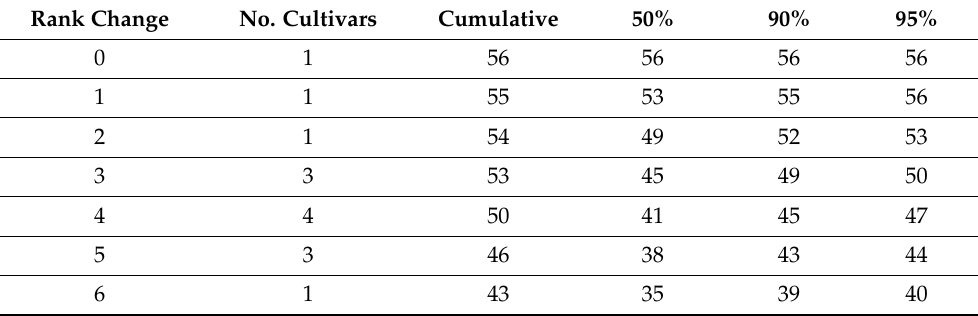
Table 9. Absolute yield rank differences for the 2008 trial. Number of cultivars shows the number of cultivars with the given rank change and Cumulative shows the number with that rank change or greater. The 50%, 90% and 95% points are from the simulated variables and show the distribution of the number of cultivars that exhibited an absolute rank change at least as large as that specified due to random variation, as described in the text.